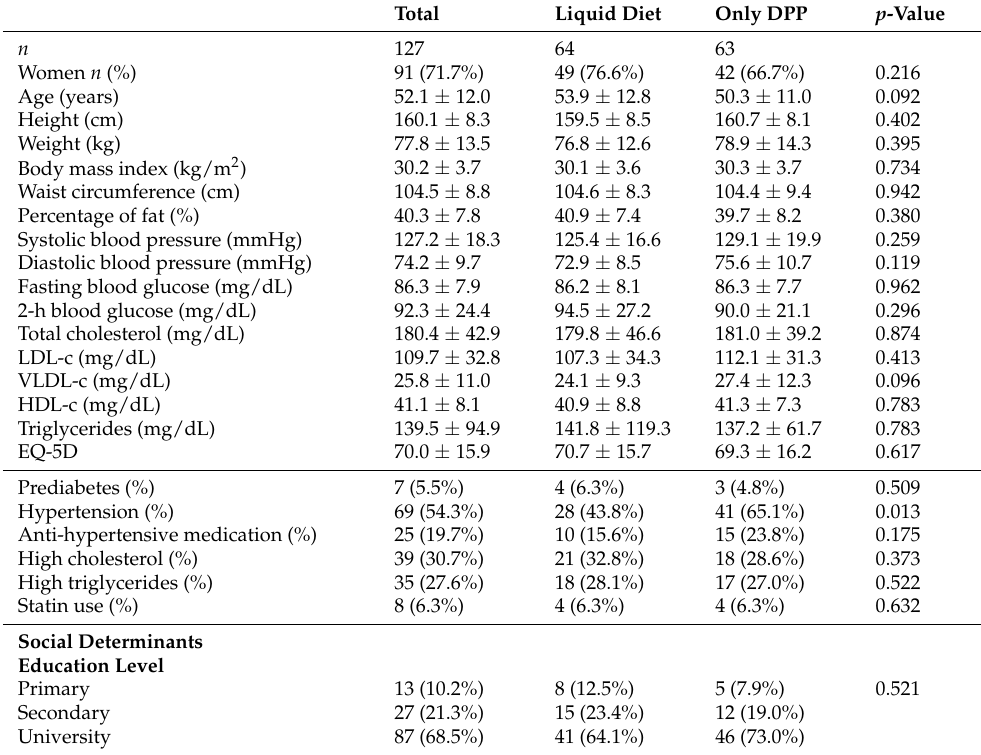
Figure 2. Fidelity of those who completed the second evaluation. * Significant difference between groups ( p = 0.001). Table 3. Baseline evaluation—characteristics of all the participants for